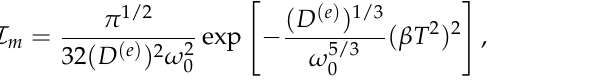
(cid:112) β , where it stays. The signal